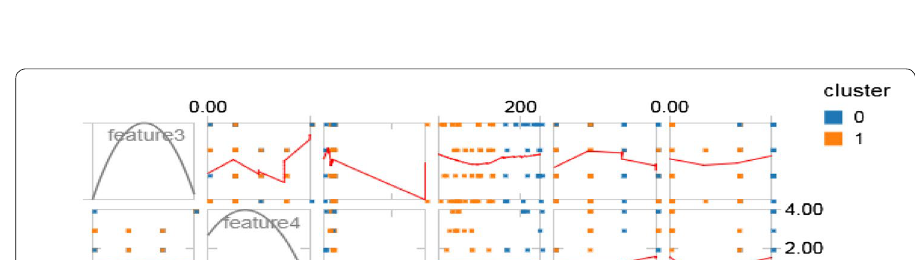
Table 9 Features summary Summary